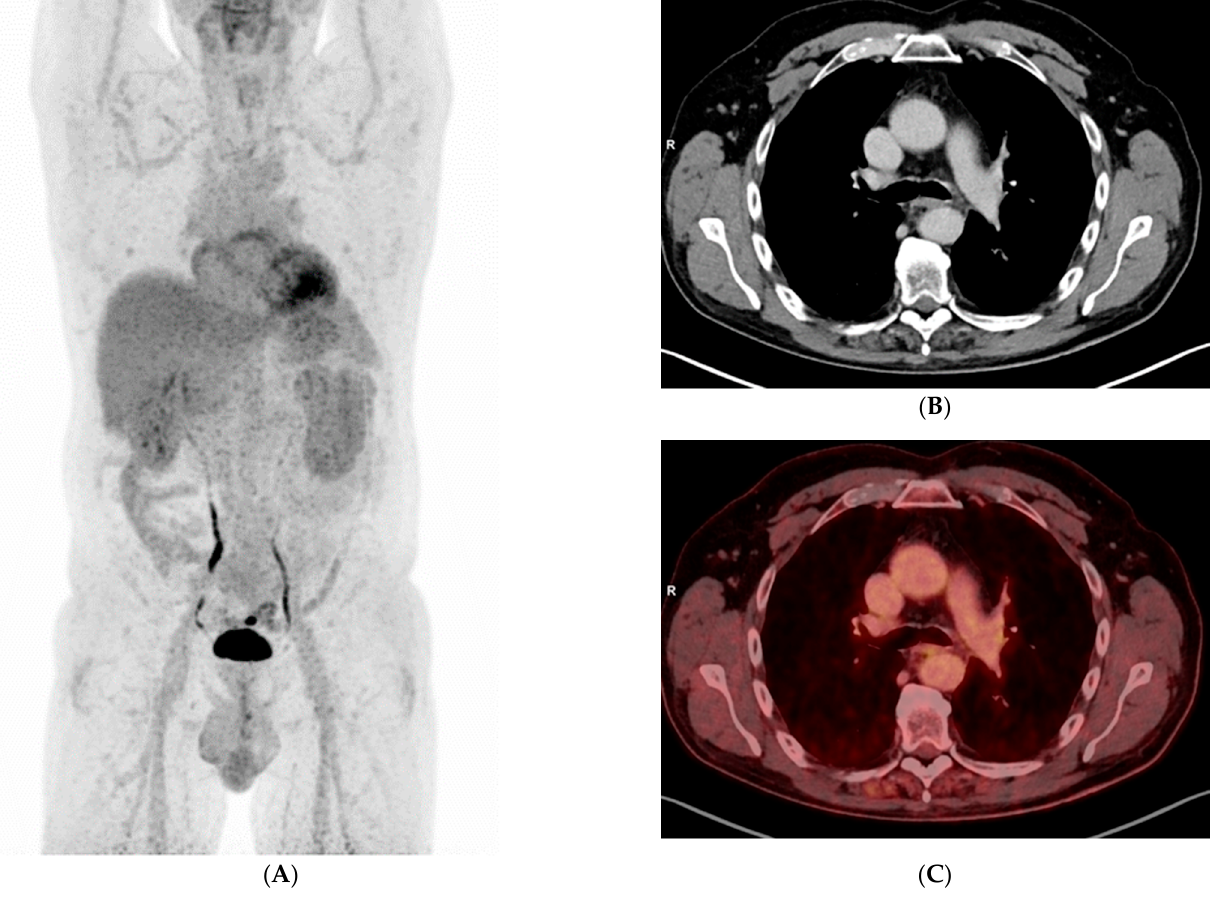
Figure 8. ( A ) MIP FDG-PET showing complete resolution of all the prior FDG-avid lesions, ( B ) transaxial CT image showing resolution of the prior tumor atelectasis complex, ( C ) same as (B) fused with FDG-PET .